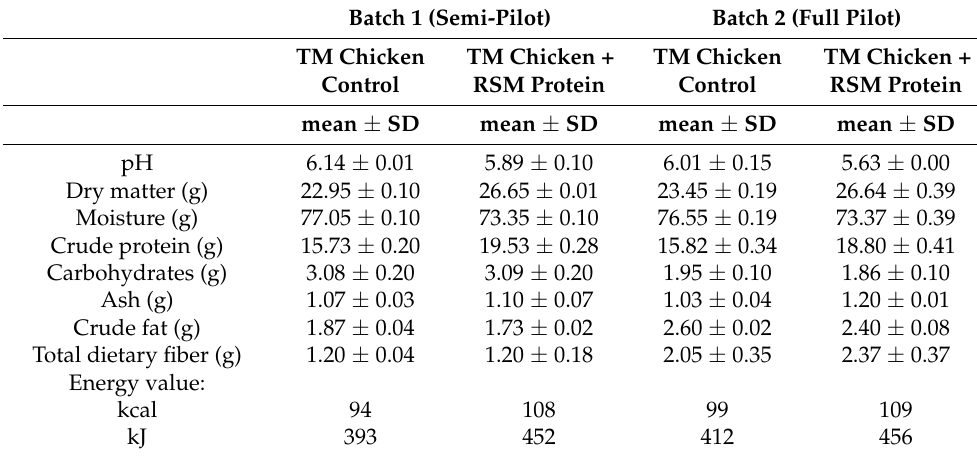
Table 5. Macronutrient composition and energy value of TM chicken breast: control and RSM-protein- supplemented (5% w/w ) samples. Values are expressed per 100 g of fresh product.